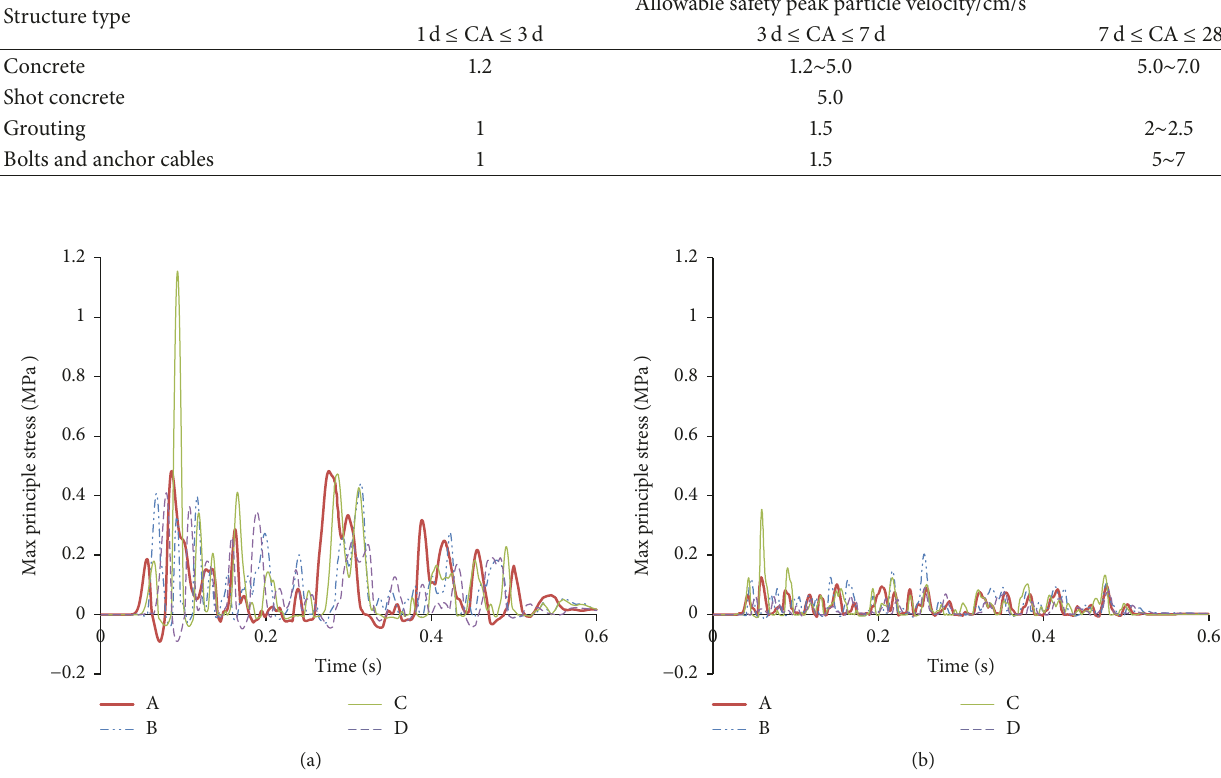
0.20.40.60.81.01.21.4